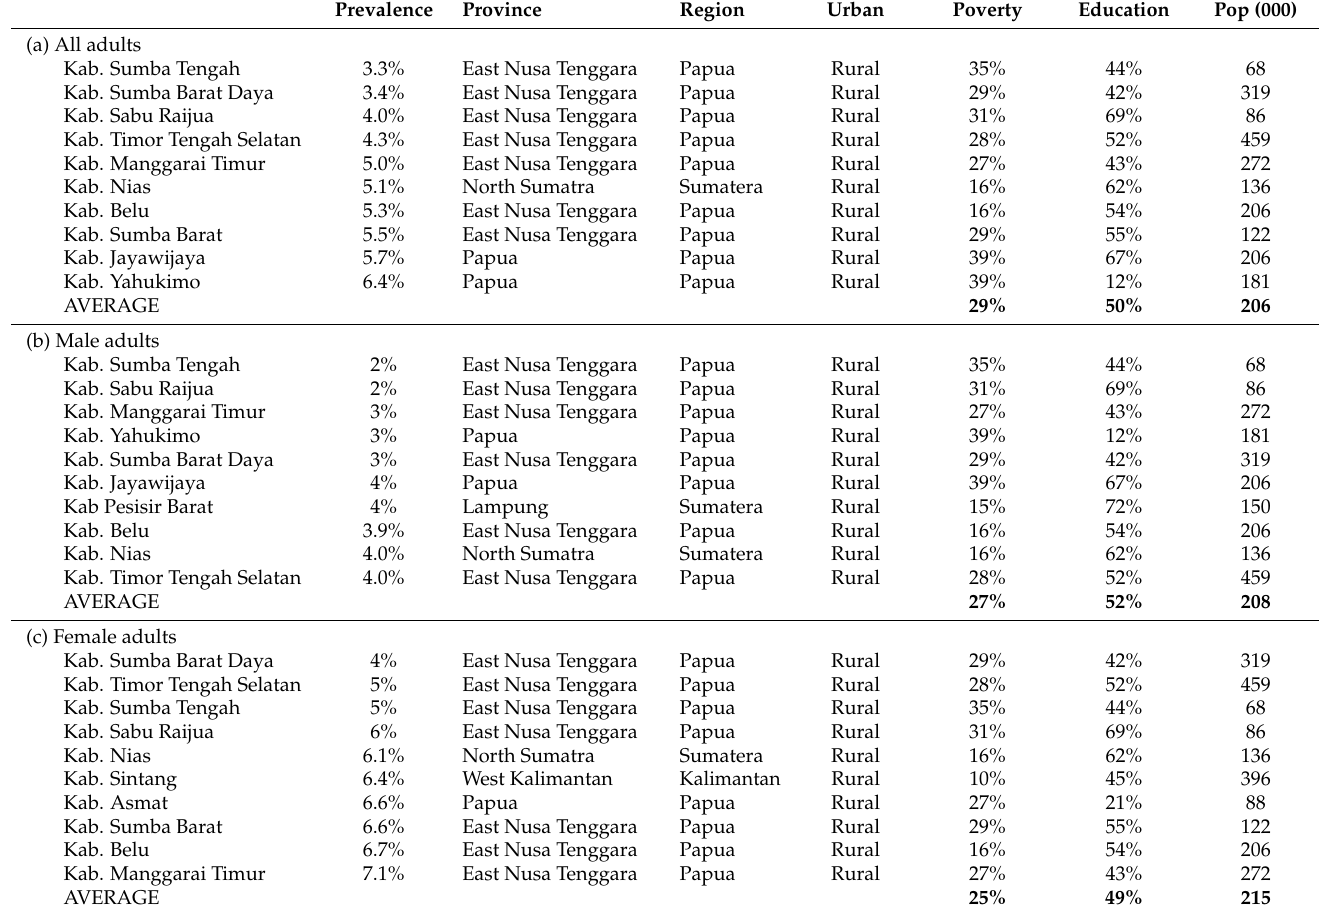
Table 3. Ten districts with LOWEST prevalence of obesity among adults in Indonesia. Prevalence Region Urban Poverty